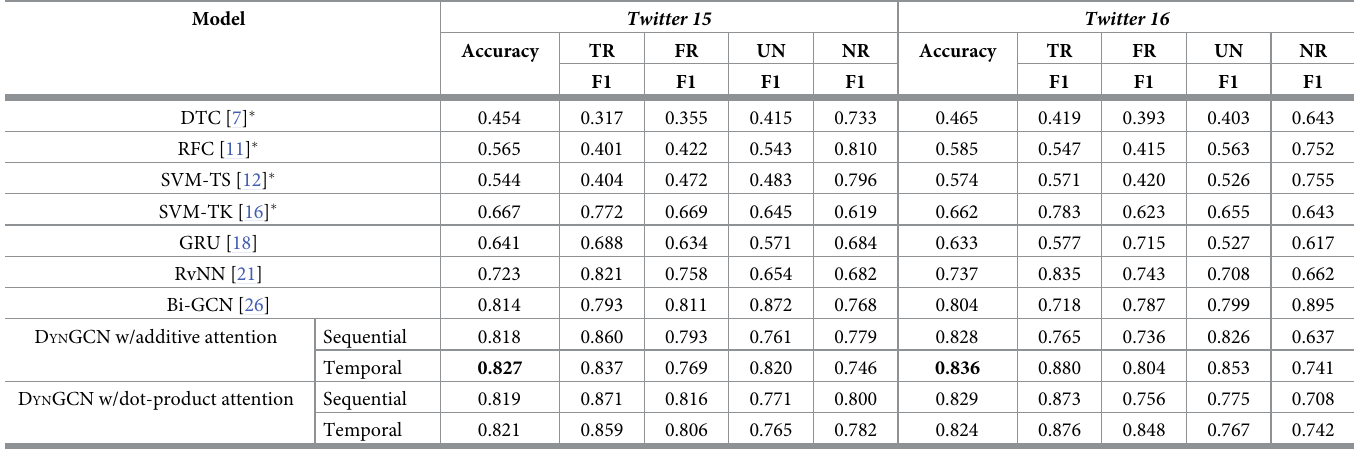
Table 2. Overall performance of rumor detection task on Twitter15 and Twitter16